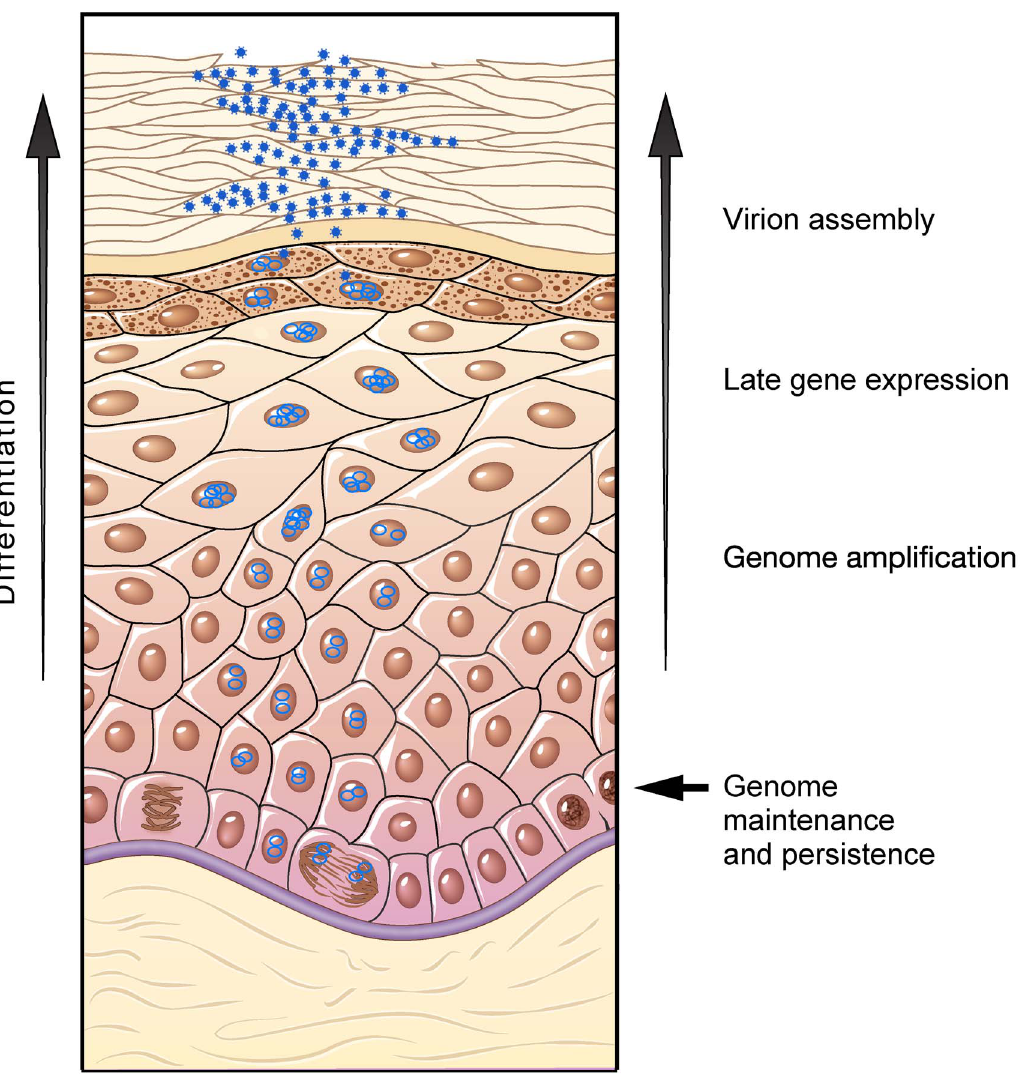
Figure 1. The papillomavirus life cycle is closely coupled with differentiation of the host epithelium. The virus infects the dividing basal cells through a microabrasion. The viral DNA is maintained at a low copy number in these cells. When basal cells divide, some daughter cells move up in the epithelium and begin the process of terminal differentiation. Papillomaviruses are finely tuned to this process and turn on late transcription, translation, and late DNA replication in specific stages of the differentiation process. Vegetative viral DNA replication takes place in cells that are in either the G2 phase of the cell cycle or have exited the cell cycle. By inducing the DNA damage response and homologous recombination repair pathways, the virus can efficiently replicate progeny genomes in differentiated cells without competition from host DNA